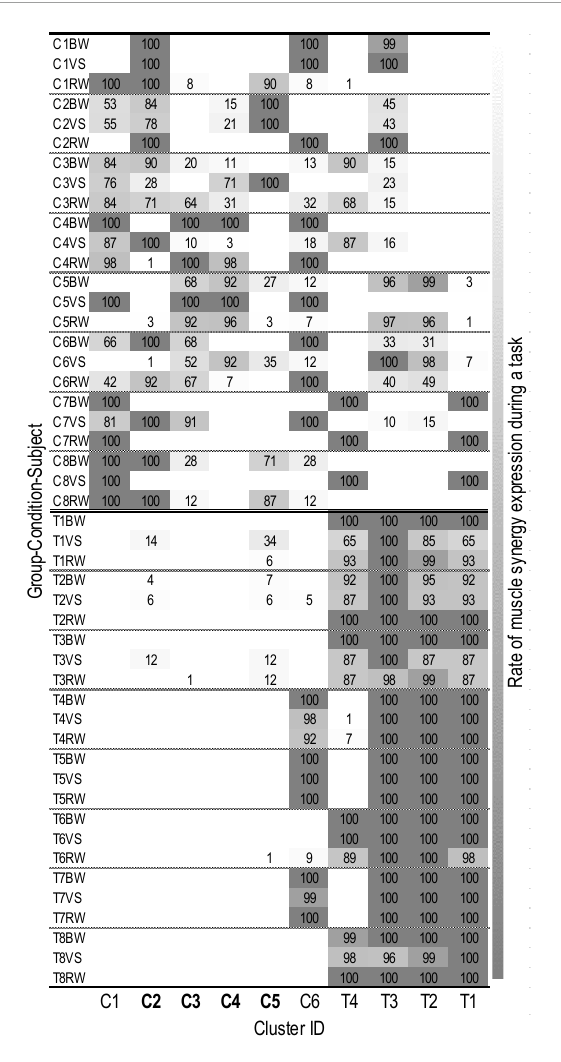
FIGURE2 Individual assignment states of muscle synergies in 10 clusters. Labels on the Y-axis are combined by group (C, cerebral palsy; T, typical development), subject ID (1 ∼ 8), and walking condition (BW, baseline walking; VS, variable speed walking; RW, restricted width walking). The X-axis is labeled as cluster ID. The cluster where the proportion of muscle synergies differed significantly depending on the walking condition is presented in bold. The number of each cell represents the rate (%) of muscle synergy expression during a given walking task (i.e., 100 indicates that the muscle synergies corresponding to a cluster are extracted from all gait cycles during a task). Lower brightness in each cell indicates a greater expression rate of muscle synergies assigned in a cluster (refer to right